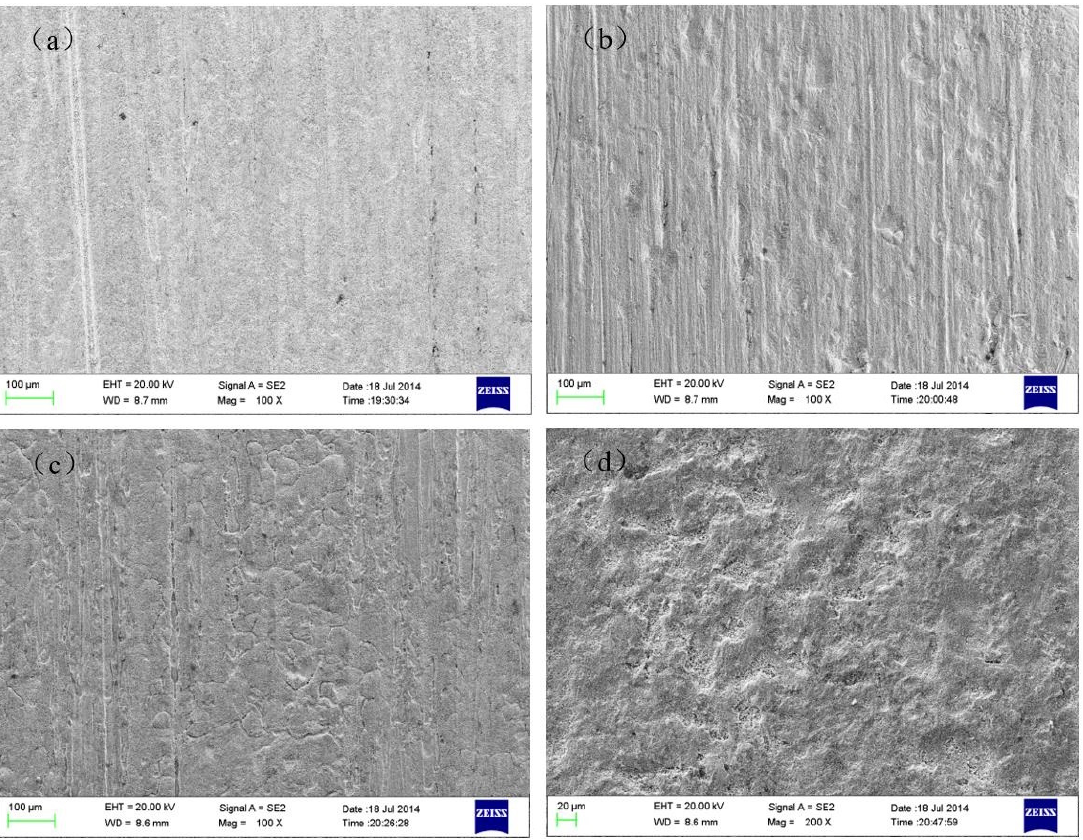
Figure 6. Morphology of the cleaned surface by SEM, ( a ) 1 week; ( b ) 2 weeks; ( c ) 4 weeks; ( d ) 8 weeks. Table 3. Contents of element Cu, Ni, and O of the cleaned surface by EDS (wt%).